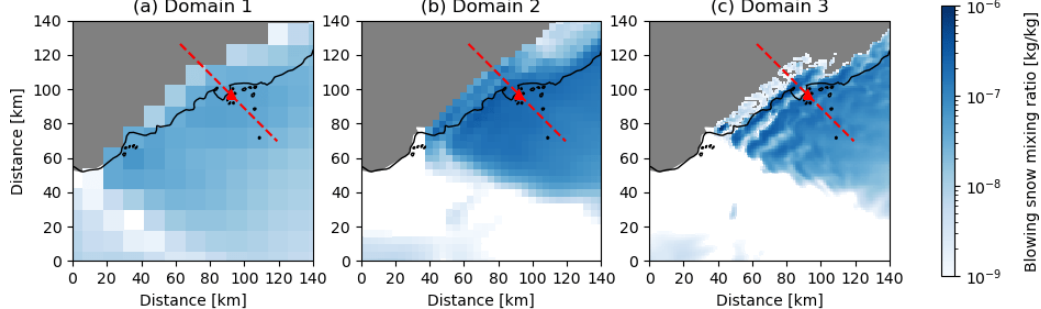
Figure 11. Blowing snow mixing ratio. Horizontal cross sections at 1500ma.g.l. on 10 August 2017 at 12:00UTC for the three domains with (a) 12km, (b) 4km, and (c) 1km resolution. The red triangle indicates the location of the DDU station. The dashed red line indicates the location of the vertical cross section shown in Fig. 12. Note that the colour bar is logarithmic.